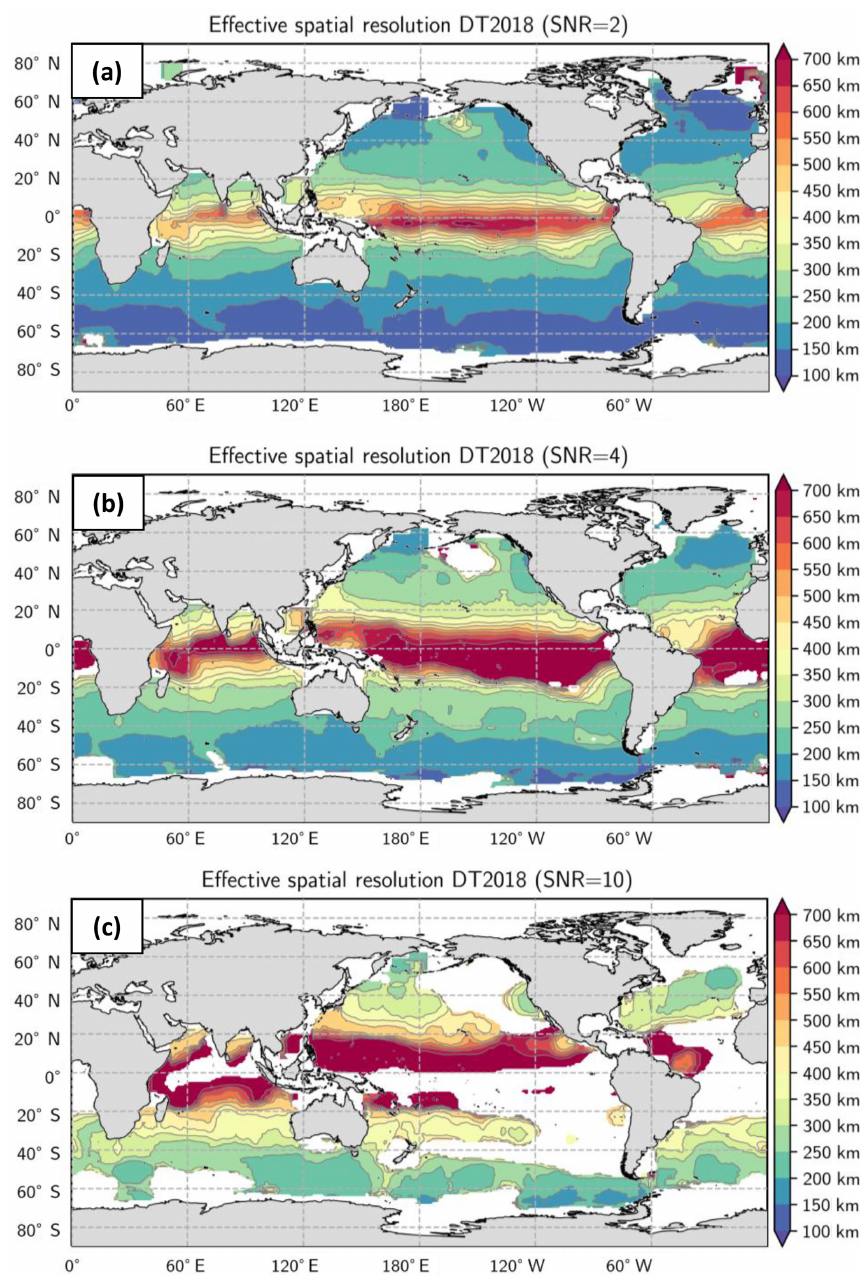
Figure B1. Effective resolution computed for three different SNR criteria: (a) SNR = 2, (b) SNR = 4 and (c) SNR = 10. The white areas correspond to the regions where the SNR threshold criterion is not